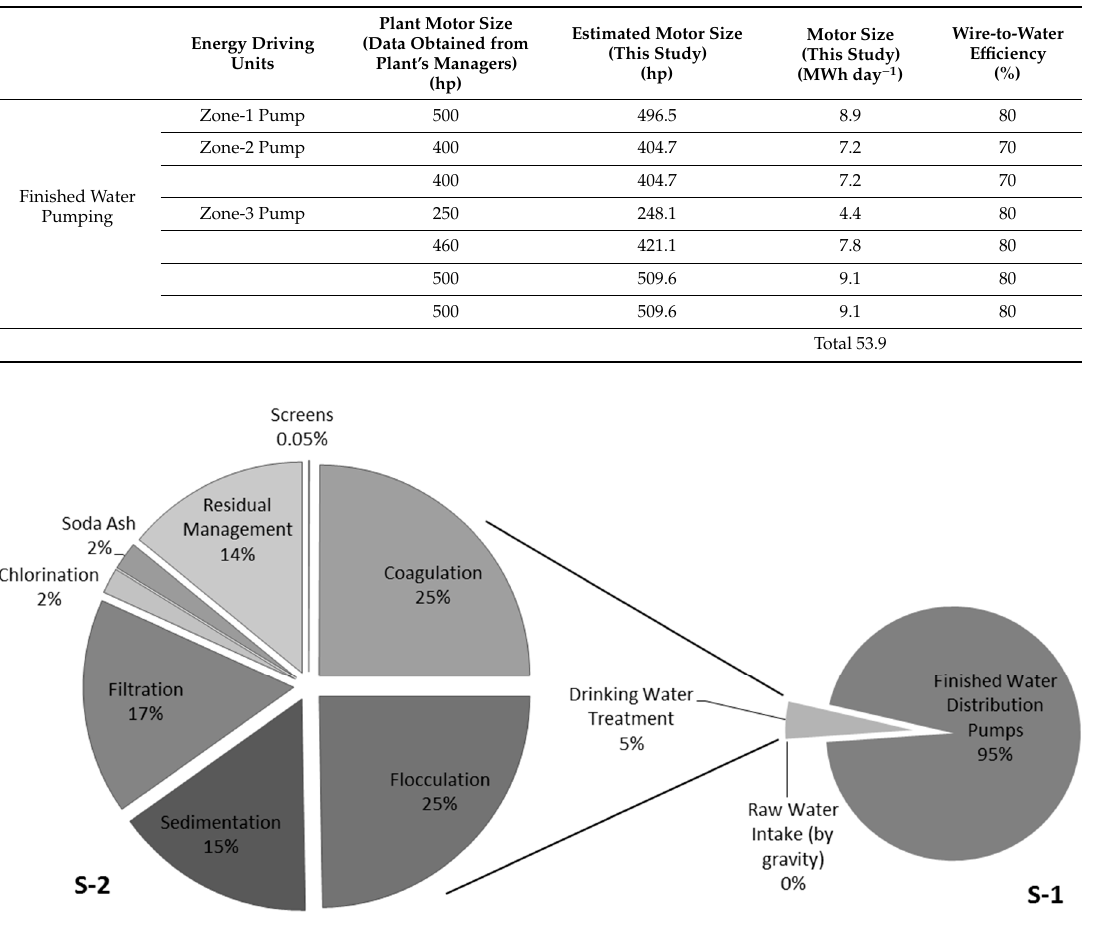
Figure 3. Results generated for the energy intensity of various unit processes of the drinking water treatment plant.